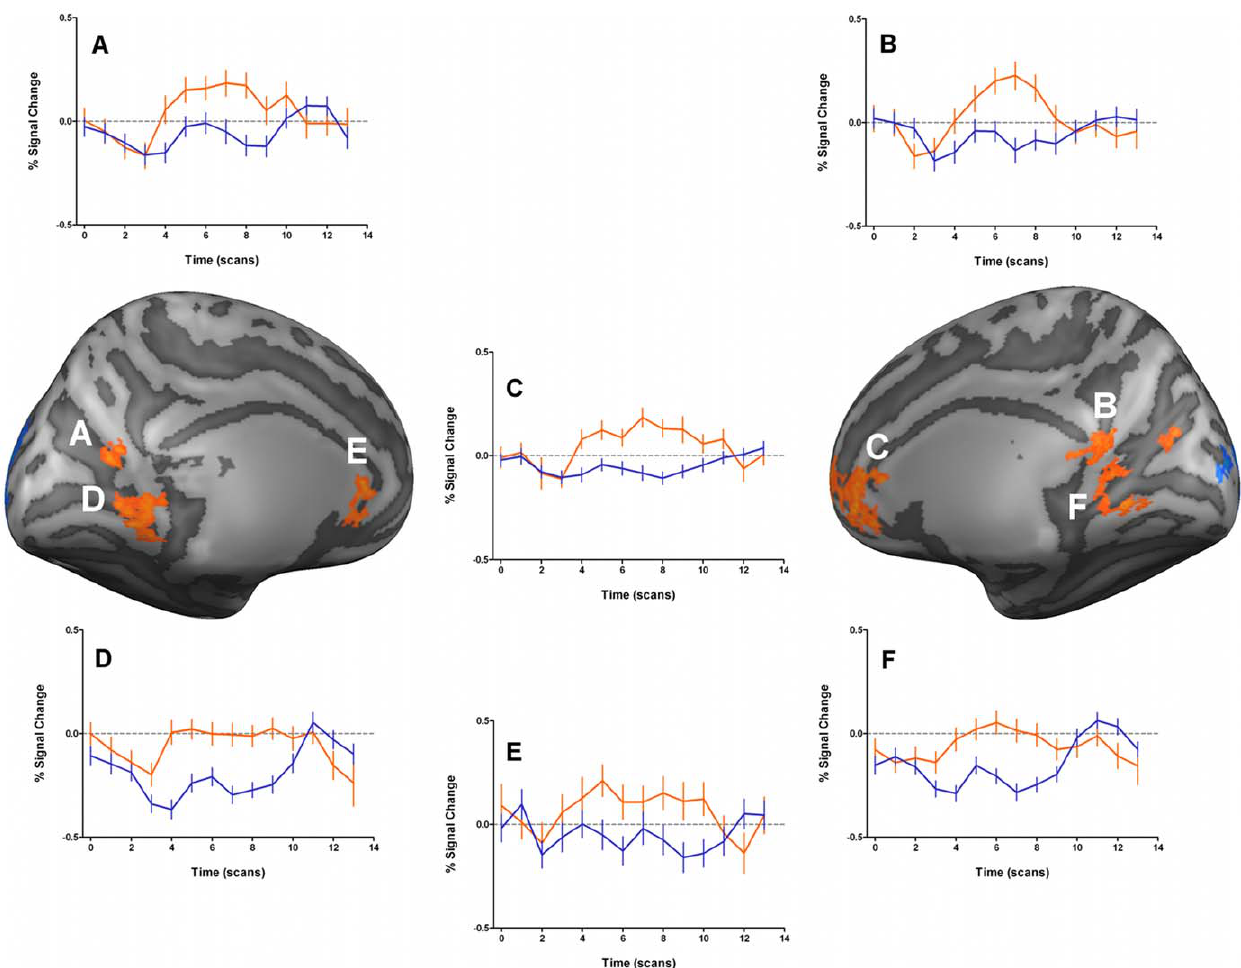
Figure 4. Time course information of the clusters with significantly higher activations for patients with NF1 than controls, regarding the M-biased stimulus for the overall (children and adults) group. Results are shown on lateral views of the left and right hemispheres of cortex-based aligned three-dimensional reconstructions generated from the average anatomical data sets of the subjects. T-maps are thresholded at p , 0.05 corrected using cortex-based cluster threshold estimation (cluster size 41 mm 2 ). Plots A to F correspond to the timecourse information for the clusters with the same letter in the cortex representations. Timecourse percent signal change is shown in orange lines for patients with NF1 and blue lines for controls. Error bars reflect mean SEs. N=28 patients with NF1 and 35 control subjects.